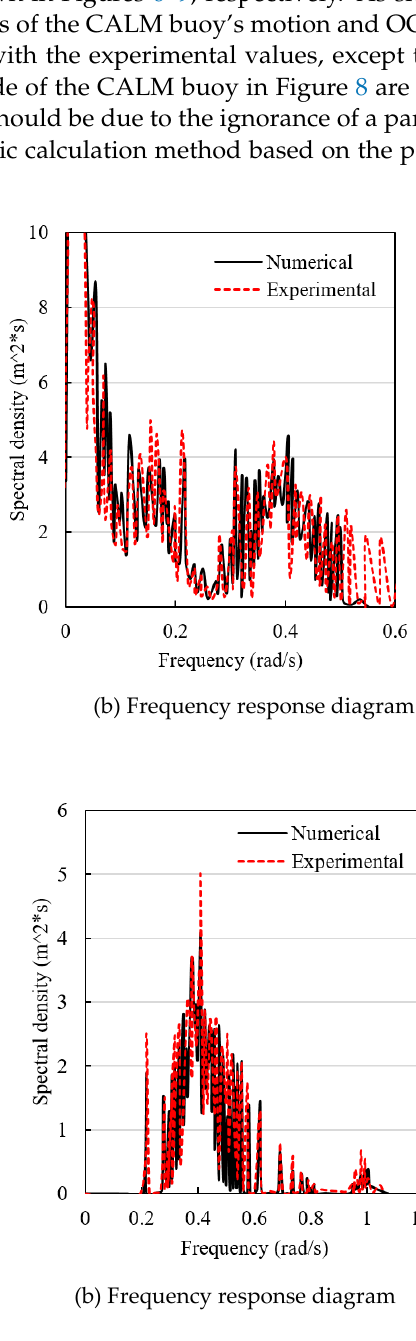
Figure 7. Heave motion of the CALM buoy.